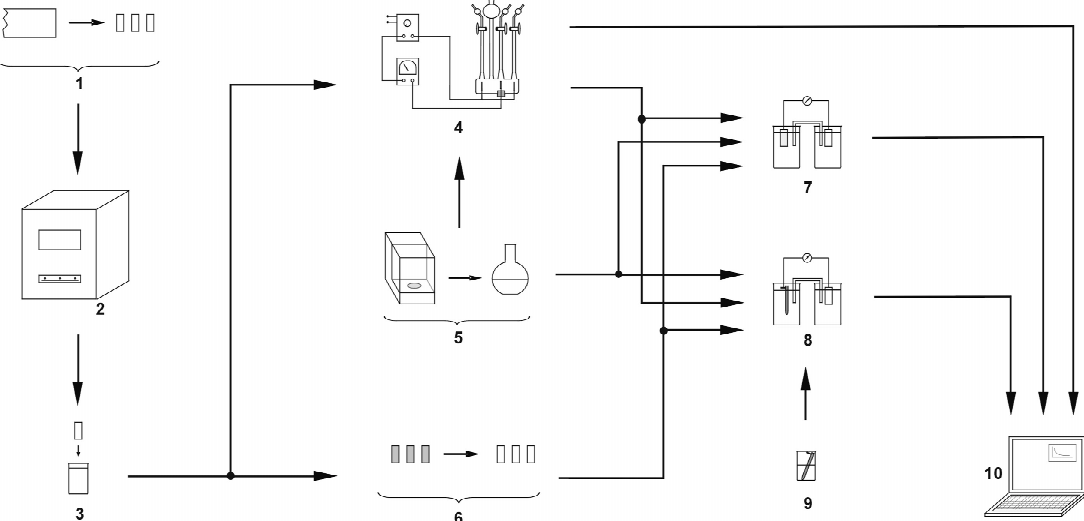
Figure 6. Preparation and experimental setups and schedule of measurements. 1: preparation of alloy samples, 2: annealing in a muffle furnace, 3: degreasing of alloy samples, 4: Hoffman apparatus, 5: electrolyte preparation, 6: removal of passive layers, 7: measurements of electrode potential after hydrogenation (or after removing passive layers), 8: measurements of cell electromotive force (EMF) after hydrogenation (or after removing passive layers), 9: preparation of calomel half-cell, 10: computer.